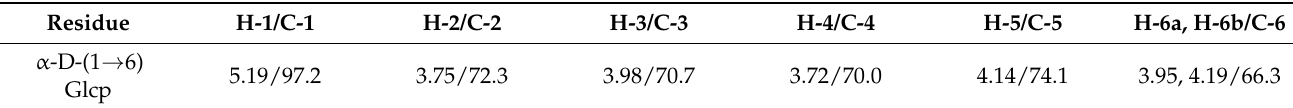
Table 4. 1 H, and 13 C NMR spectral data of the most immunostimulating polysaccharide (MPF2) from A. hemibapha subspecies javanica